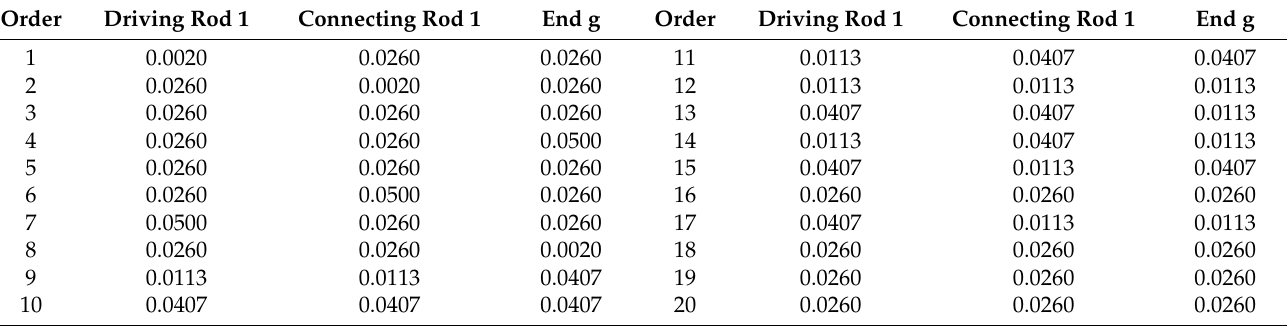
Table 4. Center composite design experimental data design table of damping